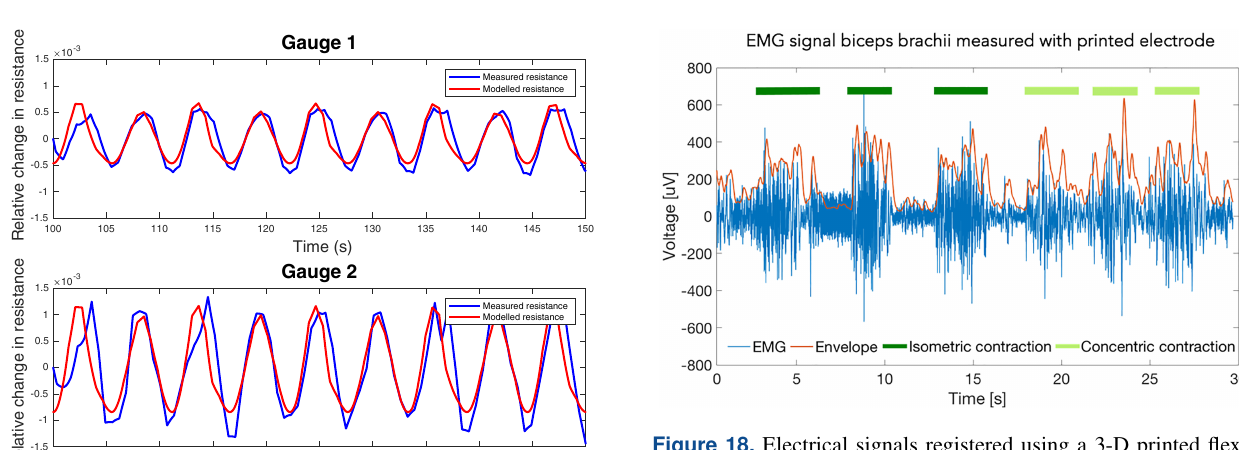
Figure 18. Electrical signals registered using a 3-D printed flexi- ble sEMG sensor. Blue: raw signal after 5Hz second-order high- pass filtering and 50Hz notch filtering. Red: envelope of the signal. Green bars indicate muscle activity.